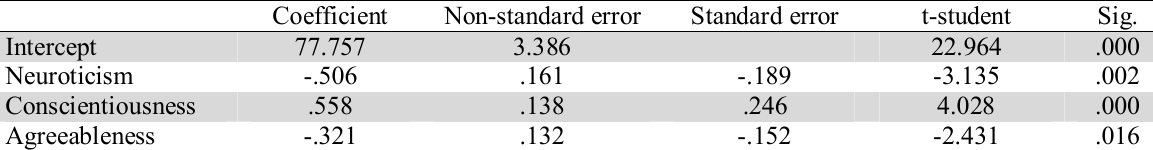
The summary of stepwise regression